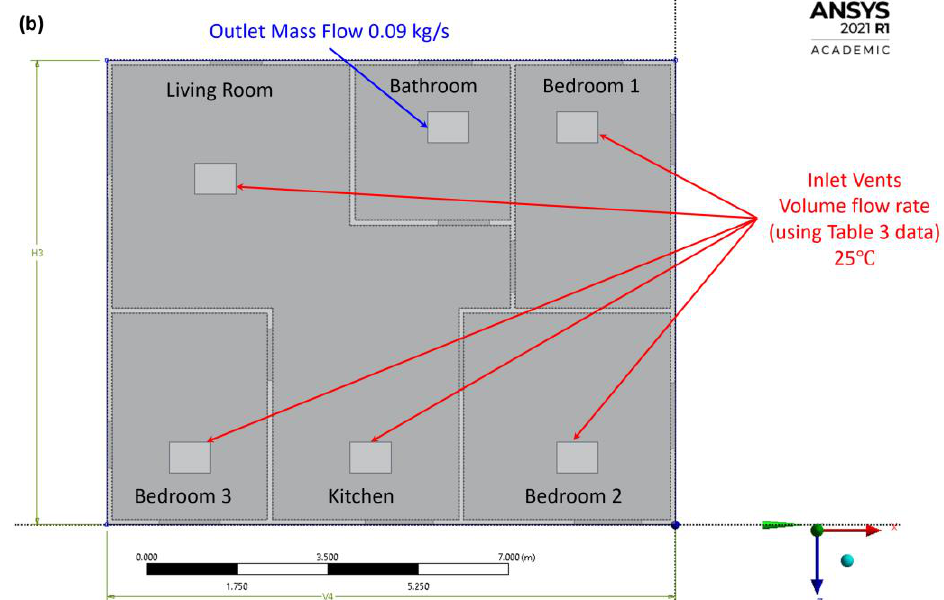
Figure 2. The computational domain with boundary conditions showing the house model containing the ducted heat pump system with the inlet and outlet vents ( a ) the iso-view and ( b ) the top view.